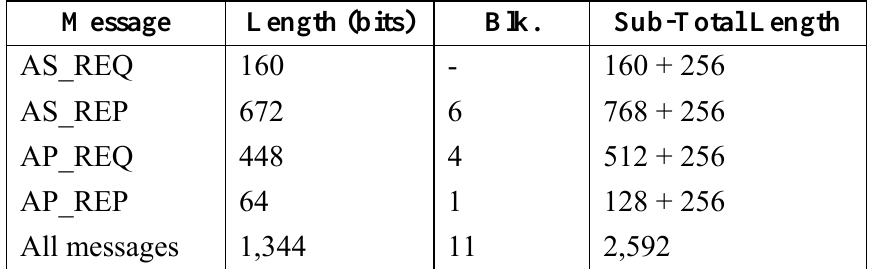
Table 4. Message length of the simplified kerberos protocol.